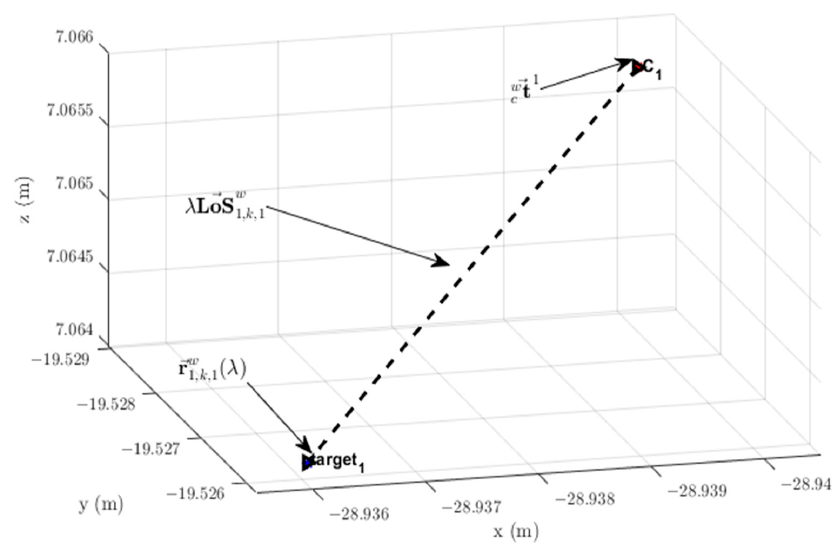
w → LoS 1, k ,1 and respective vector constraint